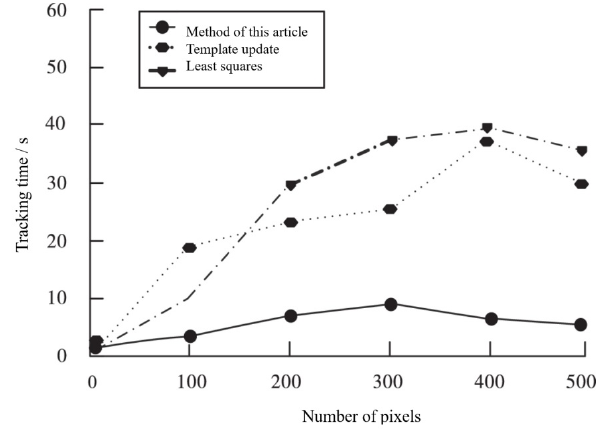
Fig. 7 Tracking time of arm trajectory in different